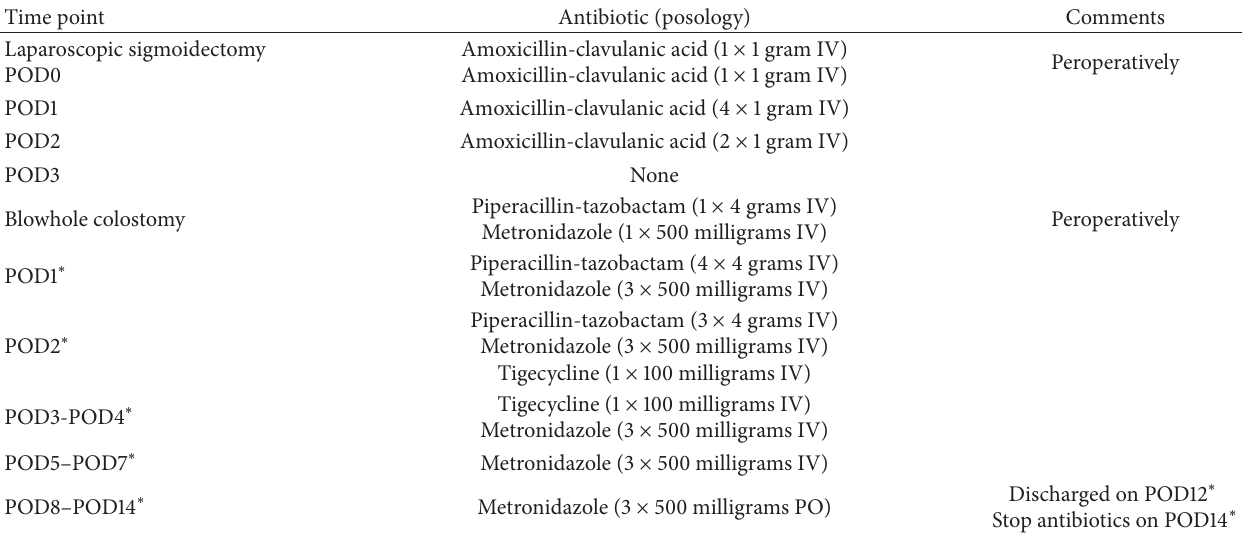
Table 1: Antibiotic